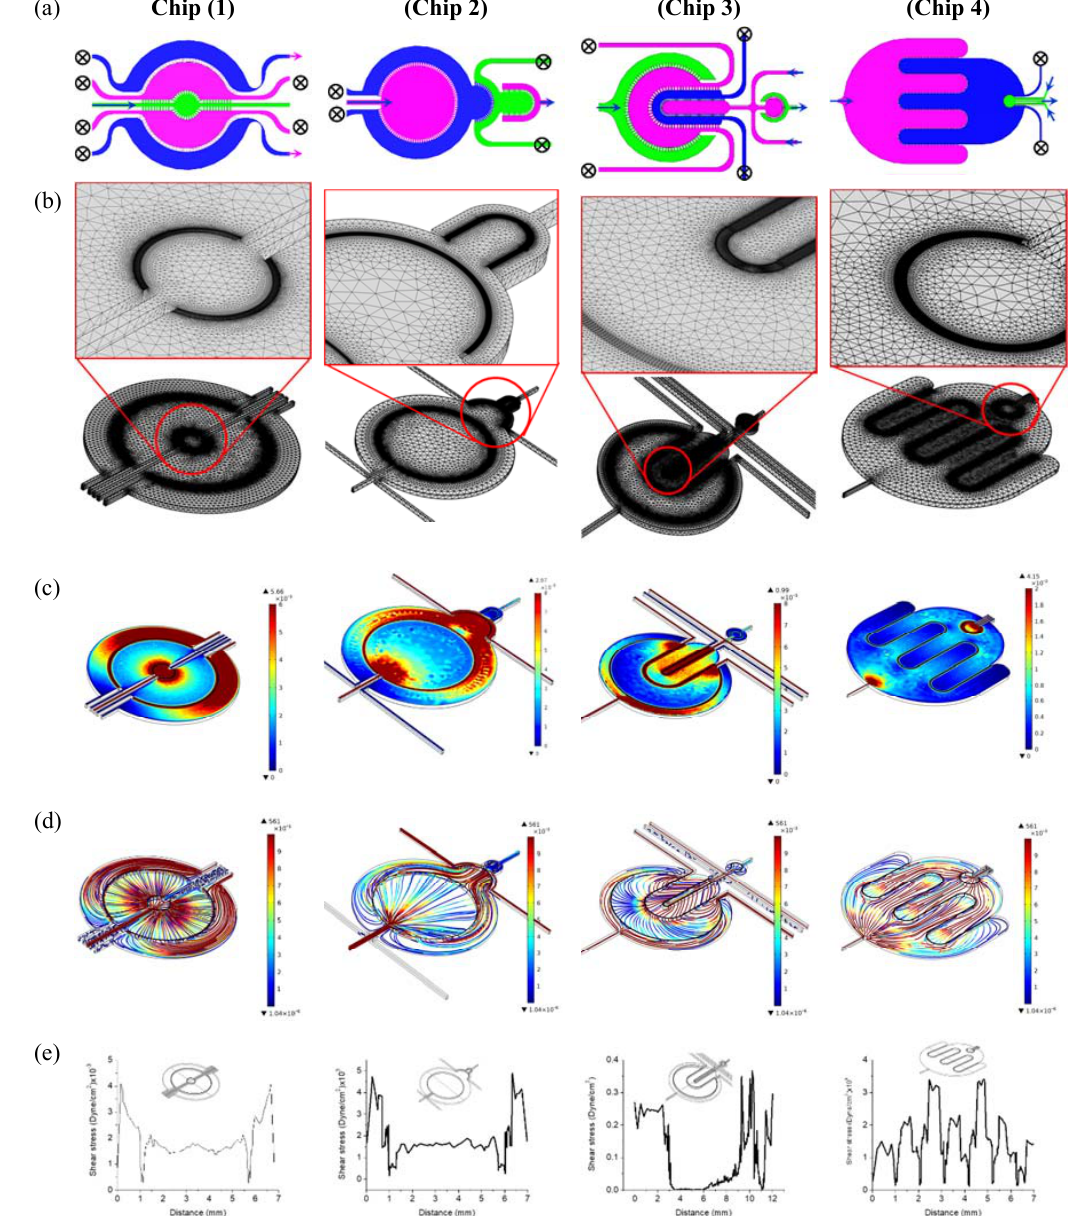
Figure 4. Finite element analysis of the flow profile within the four microfluidic chips at selected flow “in/out” configurations. ( a ) Flow conditions; ( b ) Meshed model with detailed zone of interest; ( c ) Velocity filed profile (mm/s); ( d ) Velocity profile (Streamlines); ( e ) Shear stress.